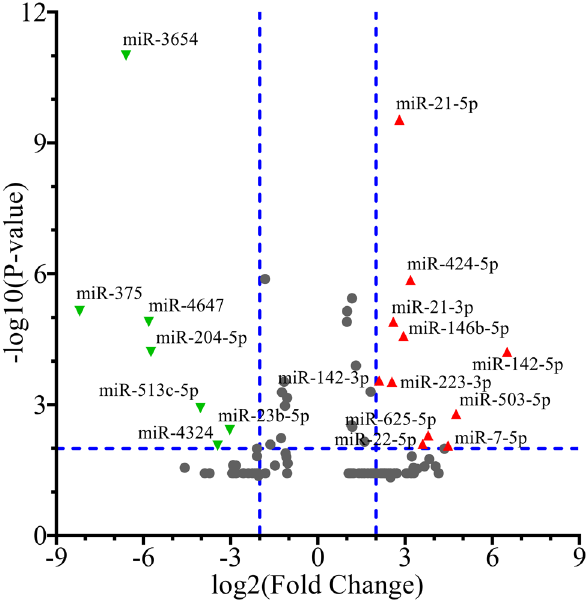
Figure 2: Di ff erential expressed miRNAs of GSE124566. Red triangles represent the 11 overexpressed miRNAs and green triangles represent the seven downexpressed miRNAs in cancerous tissues of SCCHN, respectively. Gray dots represent miRNAs with no signi fi cant di ff erence ( adjustment of p < 0.01 and fold change ≥ 4 ) . SCCHN, squamous cell carcinoma of head and